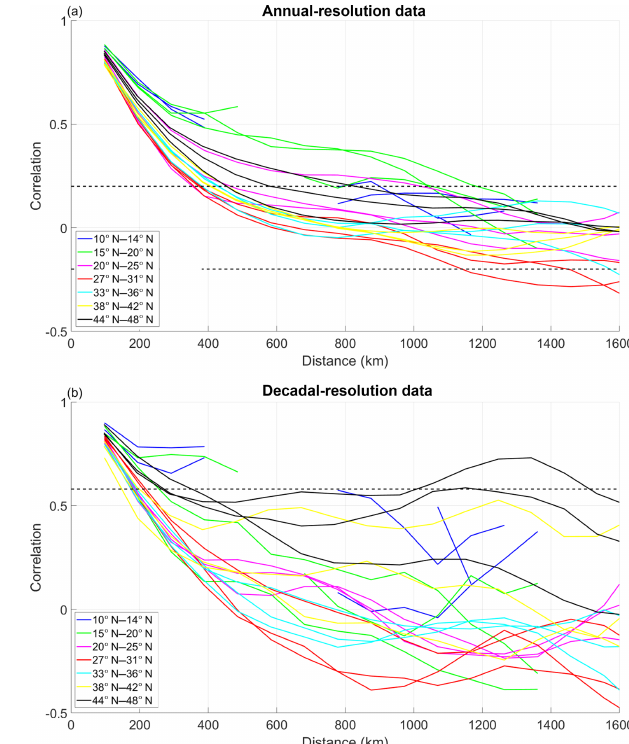
Figure 3. Correlation of simulated JJA precipitation time series across different latitudinal bands versus distance. Only the instru- mental period (years 1906–2005) and the grid points in continental Asia are considered for the calculation. (a) Annual-resolution data. (b) Decadal-resolution data. Dashed horizontal lines indicate the thresholds of statistical significance at a 95% confidence level ac- cording to the Student’s t -test. For this plot, all grid points in the same latitude band are grouped together and then one-to-one corre- lations are calculated between members of the same